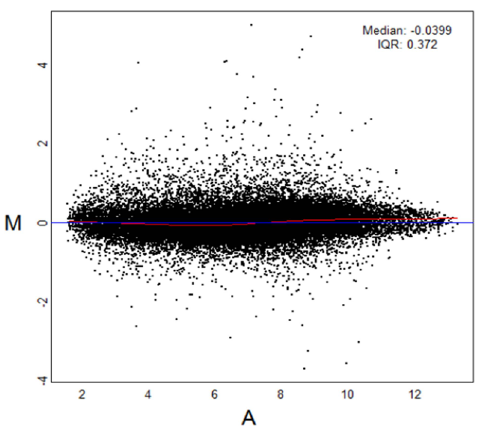
Figure 2. Main categories of genes expressed specifically in deciduous and permanent dental pulp tissues on the basis of